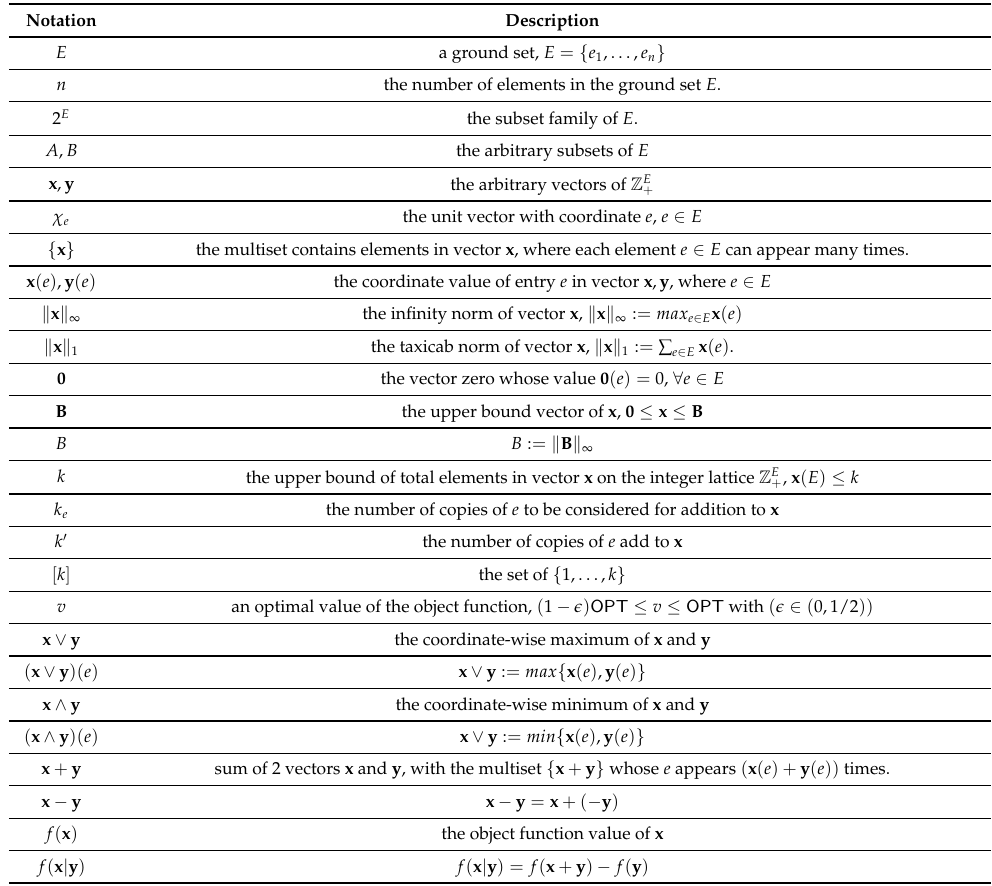
Table 2. Table of the usually used notations in this